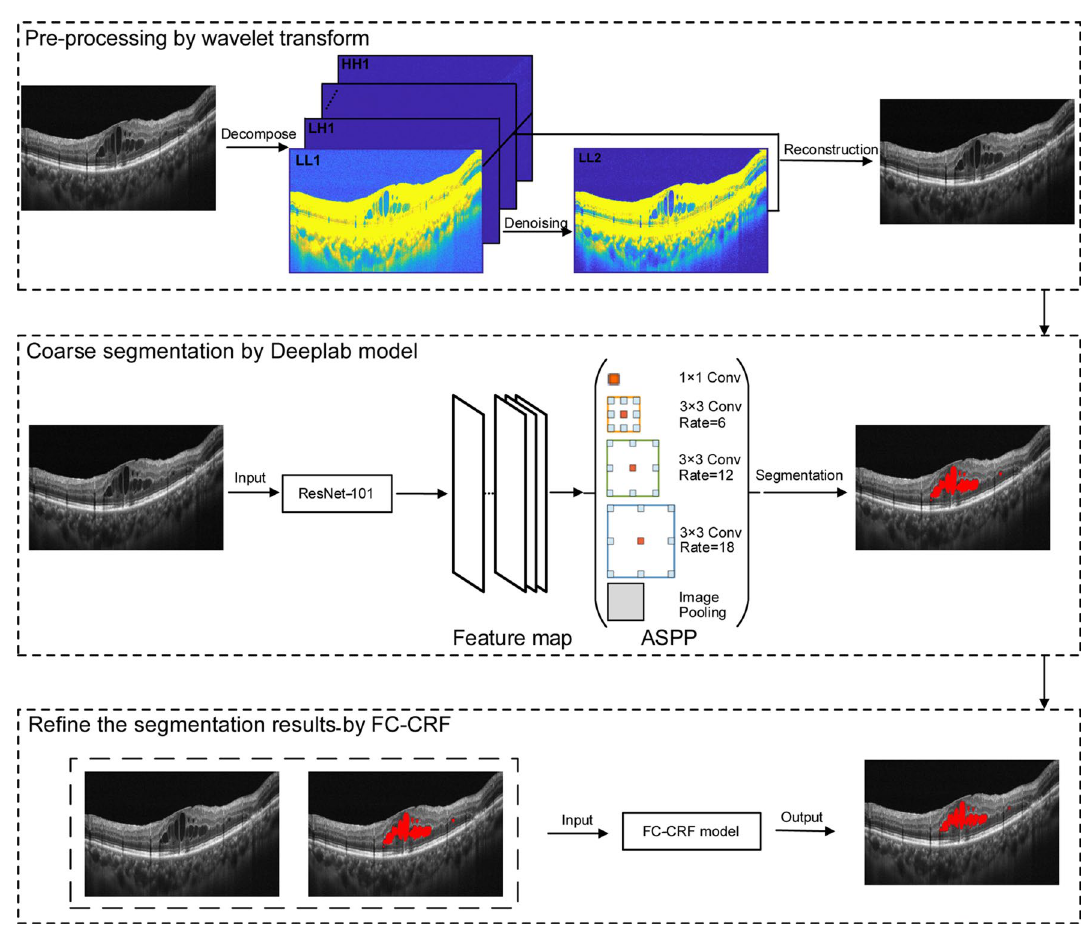
Figure 1. Flowchart of OCT-DeepLab